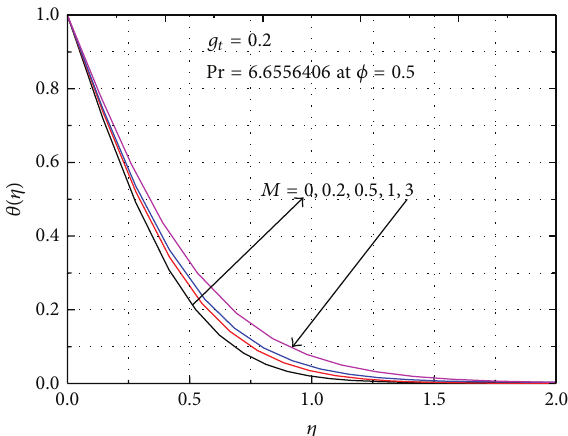
Figure 4: Effect of magnetic parameter on temperature.